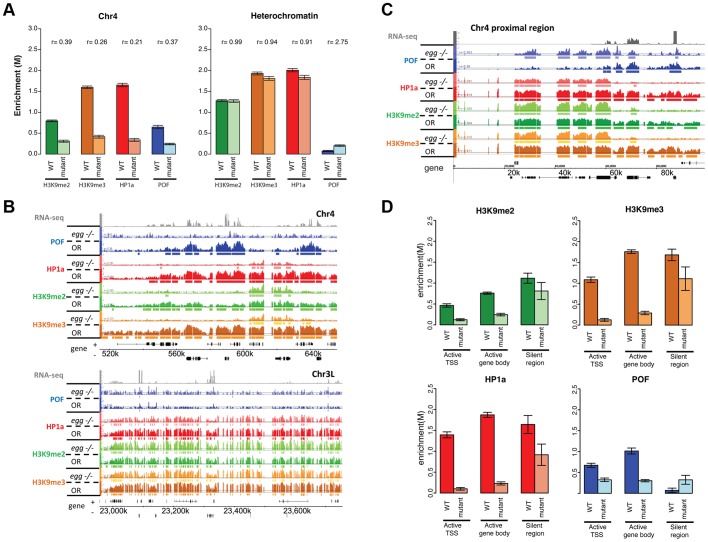
Lack of EGG leads to large-scale changes in POF, HP1a, and H3K9 methylation specifically on chromosome 4.A. Depletion of EGG alters H3K9me2/3, HP1a, and POF enrichment. Scaled enrichment is shown on chromosome 4 (left) and in pericentric heterochromatin (right) comparing wildtype (dark color) and egg 10.1-1a homozygous mutant (light color). Error bars: SEM. B. Browser shots showing the reduction of POF, HP1a, and H3K9me2/3 on chromosome 4 (top panel) and the relatively small change in pericentric heterochromatin observed in egg mutants. The M-value scale (Y-axis) is identical for wildtype and mutant ranging from 0 to 3. C. The 70 kb proximal region on chromosome 4 shows minimal changes in POF, HP1a, and H3K9me2/3 levels in egg mutants, distinct from the alterations in the remainder of the chromosome illustrated in B. The M-value scale (Y-axis) is identical for wildtype and mutant ranging from 0 to 3. D. Changes in H3K9me2/me3, HP1a, and POF enrichment (Y-axis: smoothed M-values) are examined separately for TSS of actively transcribed genes, their gene bodies, and silent regions on chromosome 4. Error bars: SEM. Data from third instar larvae.